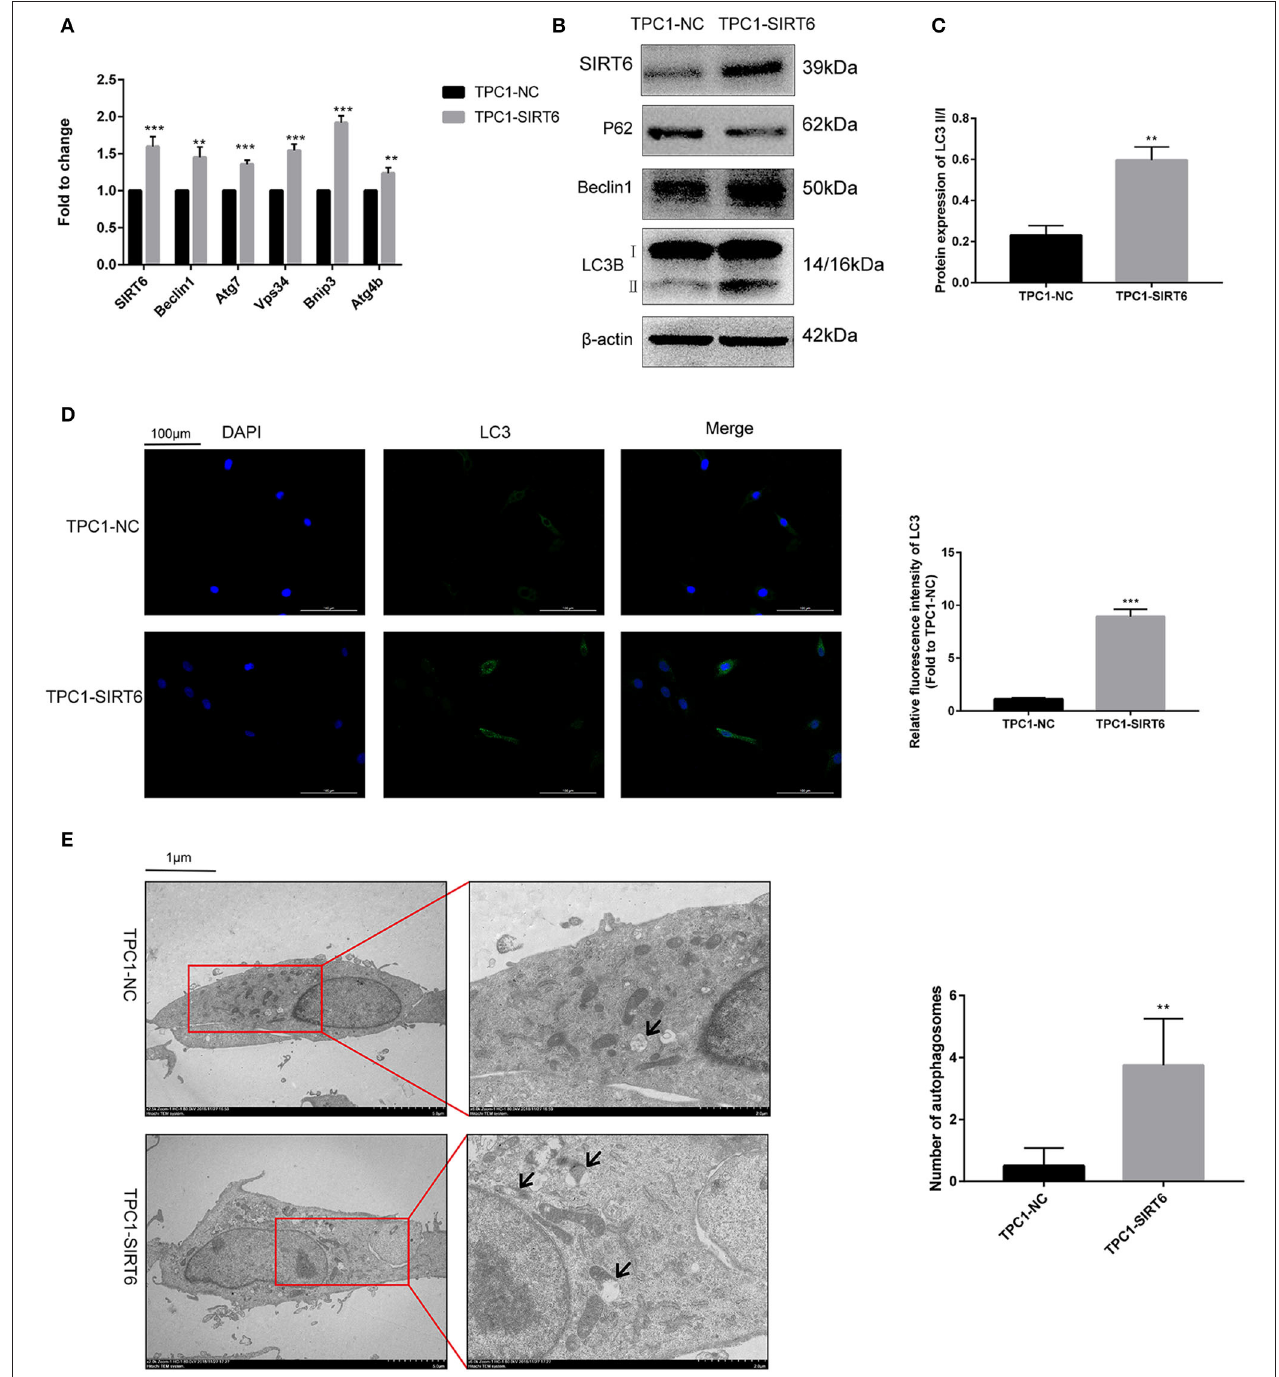
FIGURE 1 | SIRT6 induced autophagy in PTC cells. (A) The mRNA expression of autophagy-associated genes (Beclin1, ATG7, VPS34, BNIP3, and ATG4B) in TPC1-SIRT6 and TPC1-NC cells was detected using RT-qPCR. (B,C) Levels of autophagy-associated proteins (P62, Beclin1, and LC3B) in TPC1-SIRT6 and TPC1-NC cells were detected using Western blotting. (D) Images of immunofluorescence staining for LC3 in TPC1-SIRT6 and TPC1-NC cells. (E) Autophagosomes observed using TEM in TPC1-SIRT6 and TPC1-NC cells (arrow: autophagosome). (** p < 0.01 and *** p < 0.001).